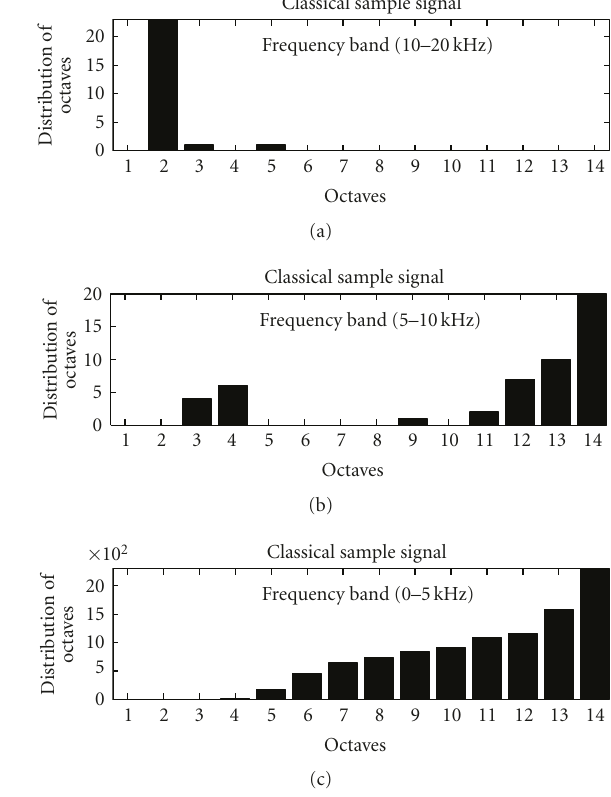
Figure 11: Octave distribution over three frequency bands for a classical